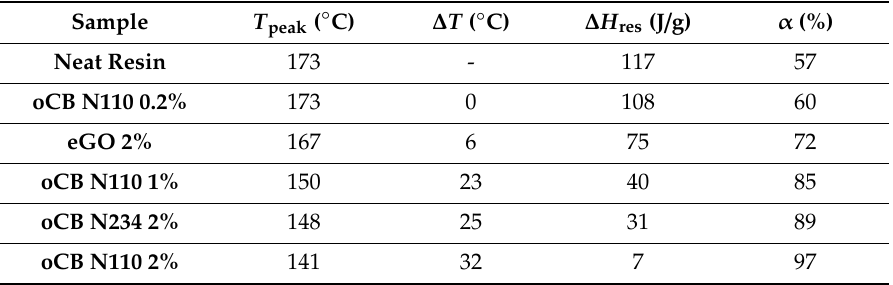
Table 2. Peak positions ( T peak ) and peak shifts (Δ T ) taken from dynamic DSC scans like those of Figures 3 and 4. Residual crosslinking enthalpies after isothermal treatment at 120 °C for 30 min (Δ H res ), as taken by DSC scans like those of Figure 6. Degree of crosslinking ( α ) after the considered isothermal treatment was calculated from Δ H res by using Equation (2).